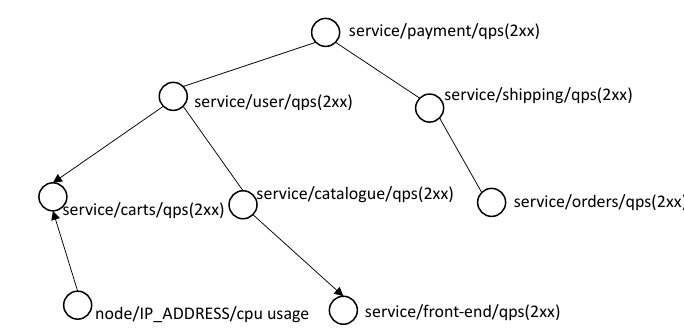
Figure 8. Explore function O&M knowledge graph in the prototype.